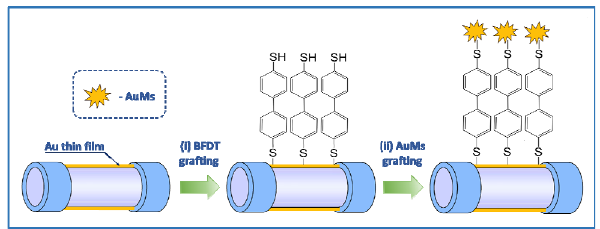
Fig. 1 Schematic representation of the preparation of the hybrid plasmonic sensor based on the plasmon coupling between the thin gold layer deposited on the multimode fiber surface and grafted with (i) dithiol and (ii) AuMs with sharp